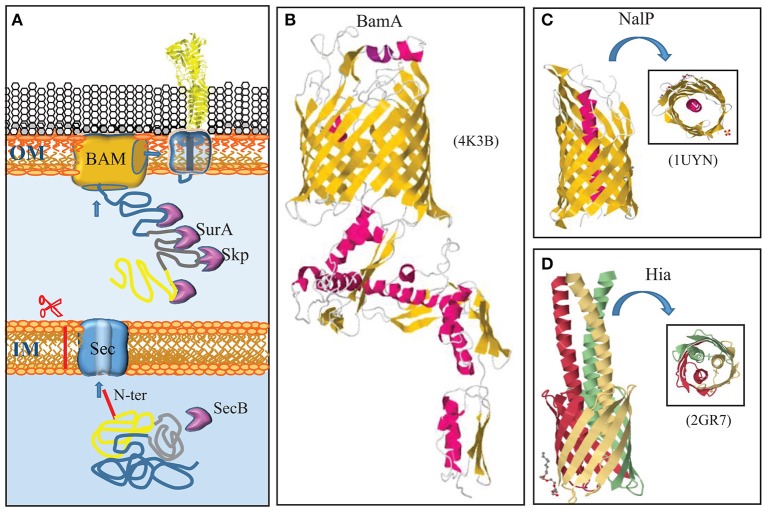
Autotransporter secretion system. (A) Autotransporters use the same machinery to reach the outer membrane (OM) as integral OMPs. They are synthesized with a cleavable N-terminal signal sequence (red) for translocation across the inner membrane (IM) via the Sec translocon. After periplasmic transit, escorted by chaperones like Skp and SurA, the C-terminal β-domain (blue) is integrated as a β-barrel into the OM by the BAM complex. Presumably during this integration, the passenger domain (yellow) is transported to the cell surface. A segment that connects the passenger with the β-domain (gray) forms an α-helix that plugs the channel within the barrel. (B) Structure of the central component of the BAM system, BamA, from N. gonorrhoeae (Noinaj et al., 2013). BamA is constituted of a β-barrel in the outer membrane and five periplasmic POTRA domains. α-Helices and β-strands are shown in red and yellow, respectively. (C) Structure of the β-domain of the autotransporter NalP with the α-helix that plugs the β-barrel and exposes the passenger, if connected, at the cell surface, indicated in red (Oomen et al., 2004). (D) Structure of the β-domains of the trimeric autotransporter Hia of H. influenzae (Meng et al., 2006). Each subunit is indicated with a different color. In panels (C,D), a top view is shown in the insets. The structural data were retrieved from the Protein Data Bank (PDB) and access codes are provided in brackets. References are provided in the text.